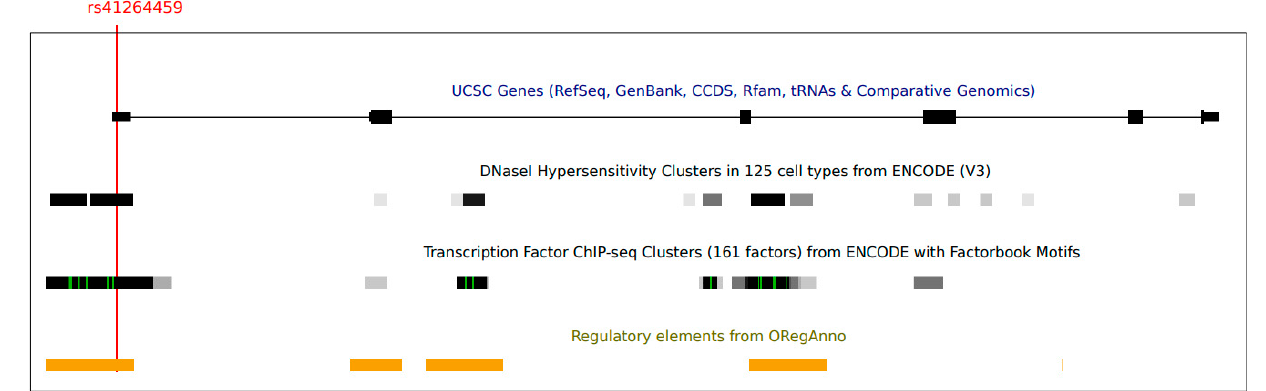
Figure 1. A screenshot from the UCSC genome browser (http://genome.ucsc.edu/, GRCh37/hg19, accessed on 1 December 2022). The panel shows the AIM2 gene and the informative tracks showing DNase hypersensitive areas (from ENCODE), regions of transcription factor binding (from ENCODE), literature-curated regulatory regions and transcription factor binding sites (from OregAnno). The position of variant rs41264459 is also reported.